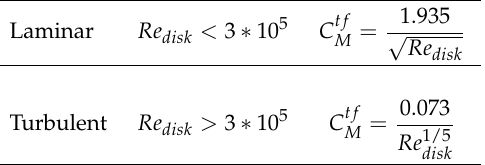
Table 3. Moment coefficient on the disk for the Free configuration.